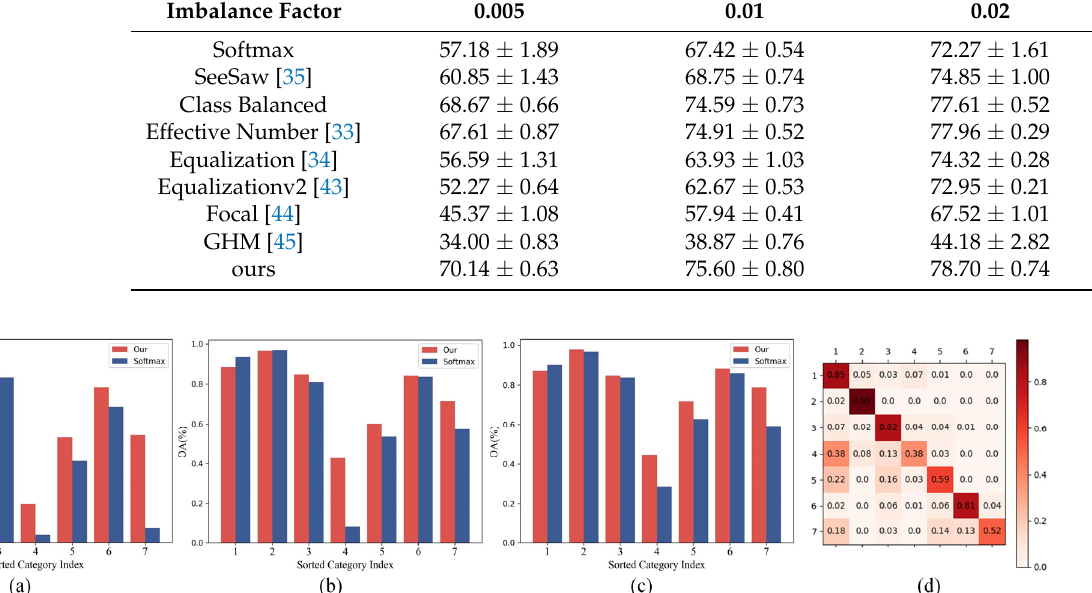
Table 2. Comparison results of the proposed method with other similar advanced methods on the long ‐ tailed HistAerial dataset with imbalance factors of 0.005, 0.01, and 0.02. The values in the table are the top1 OA (%).